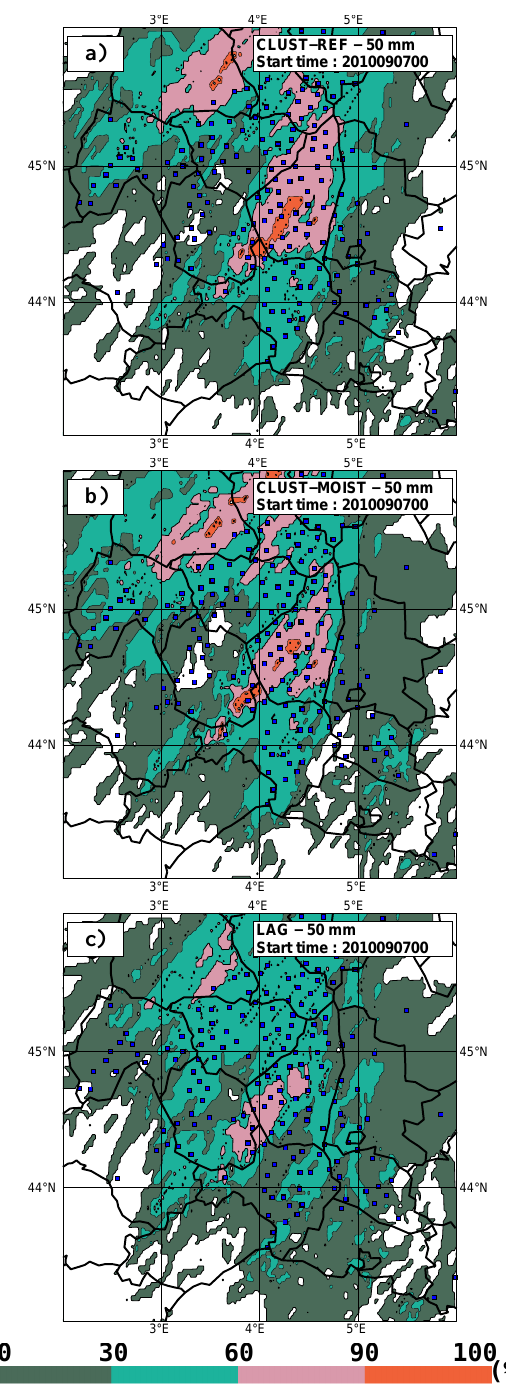
Fig. 14. Gard case probability map for the 24-h accumulated precipitation (valid at 06 UTC on 08 September 2010) exceeding 50 mm and for : a) CLUST-REF , b) CLUST-MOIST and d) LAG . The squares are observations (rain-gauges) over the same threshold.